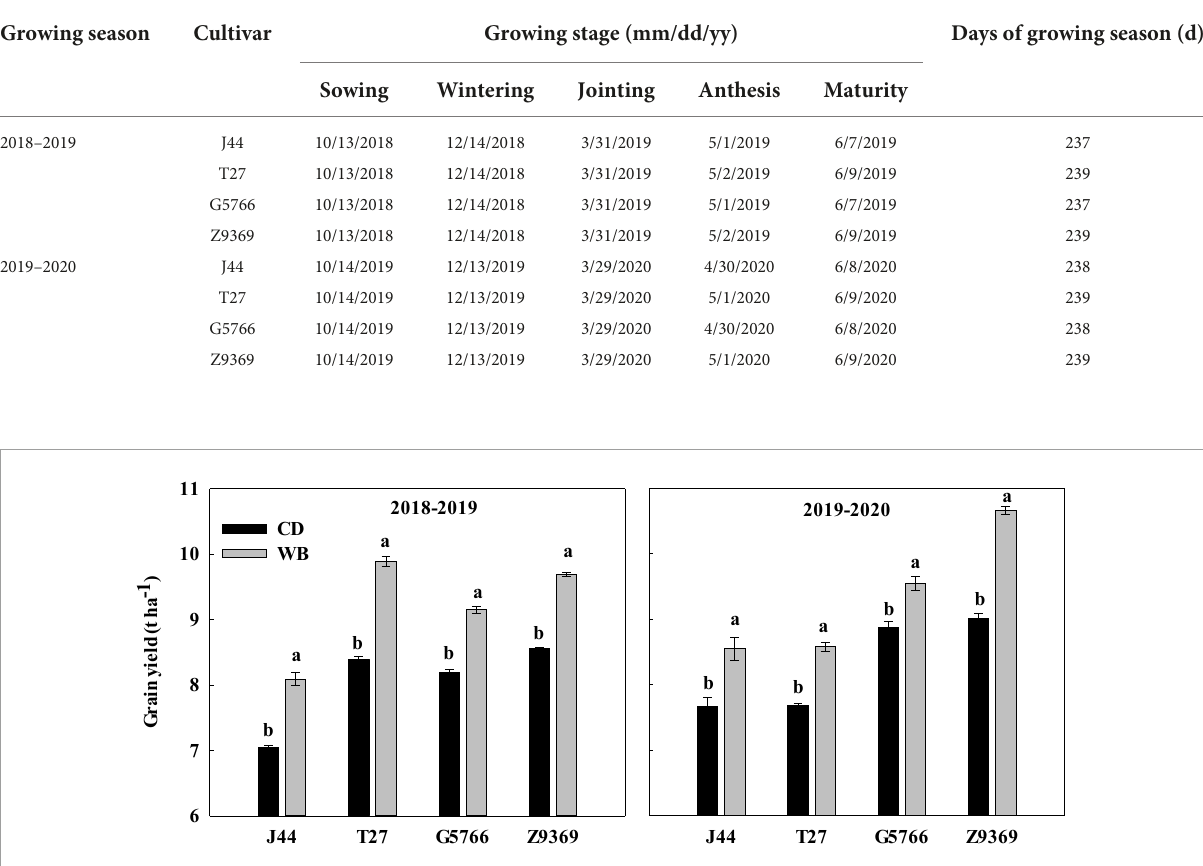
TABLE 1 The date at which bread wheat reached sowing, wintering, jointing, anthesis, and maturity stages for cultivars.